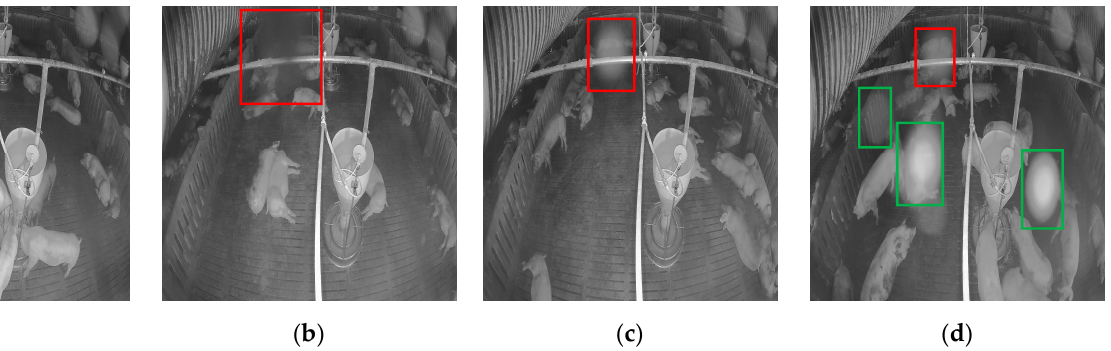
Figure 1. The formation of a haze spot caused by insect secretion: ( a ) clean image before the appearance of a haze spot; ( b ) an insect lands on the camera; ( c ) a haze spot formed after the insect left; ( d ) more haze spots appeared a few days later.